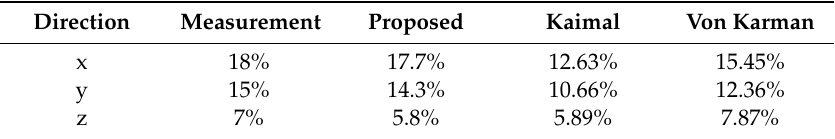
Figure 4. Comparison of the power spectrum. ( a ) x -direction; ( b ) y -direction; ( c ) z -direction. Table 2. The comparison of turbulence